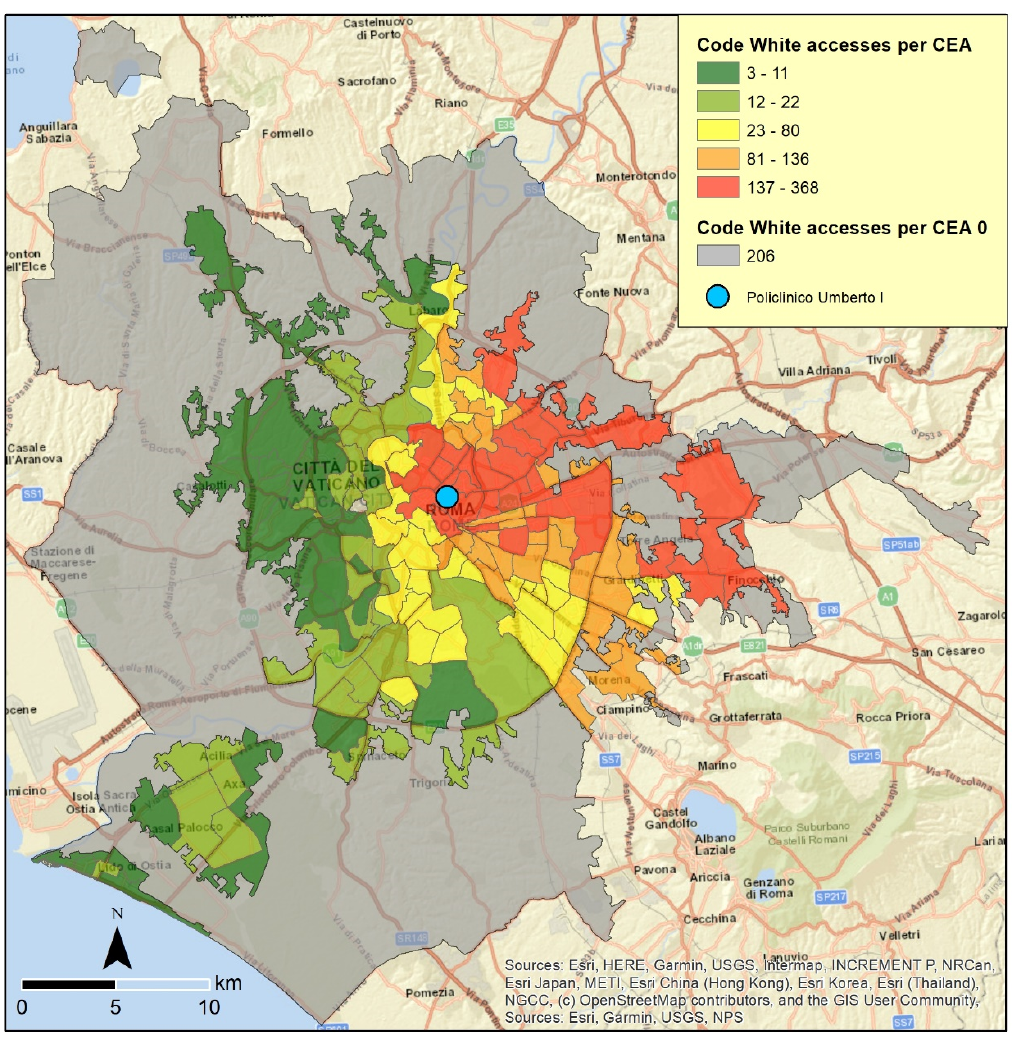
Figure 4. Accesses in code white recorded by the Policlinico Umberto I emergency room with data aggregated on the basis of census areas. Source: authors’ elaboration.